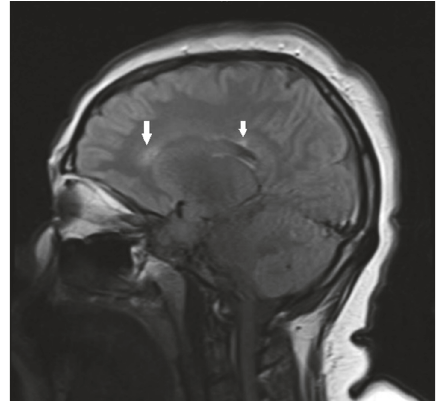
Figure 2: FLAIR sagittal images of the brain showing perical- losal hyperintensities. FLAIR: fluid- attenuated inversion recovery